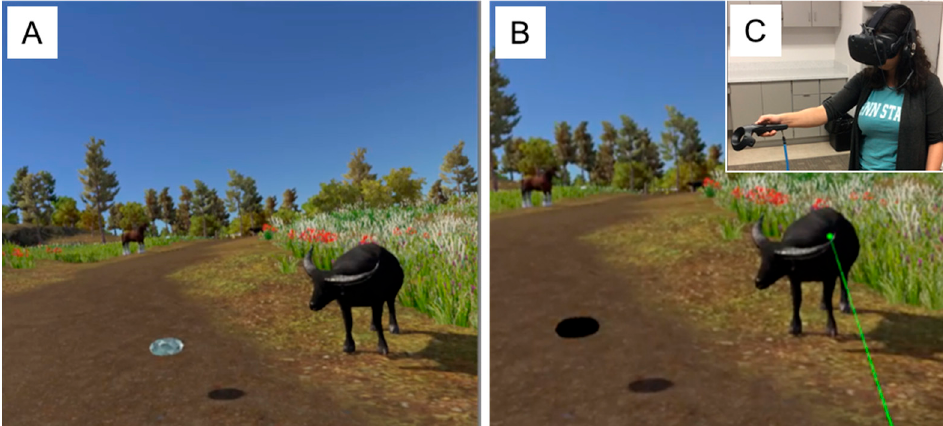
Figure 3. iVR Zoo interactions. ( A ) Participants used their handset to click on animals with a floating gem next to them. ( B ) Once participants successfully clicked on an animal, the gem turned black. During the practice session, no sound was heard when participants clicked on animals. During the actual L2 learning, participants heard the Chinese word for the corresponding animal whenever they clicked on them. ( C ) Position of an individual clicking on the animal in panel B.